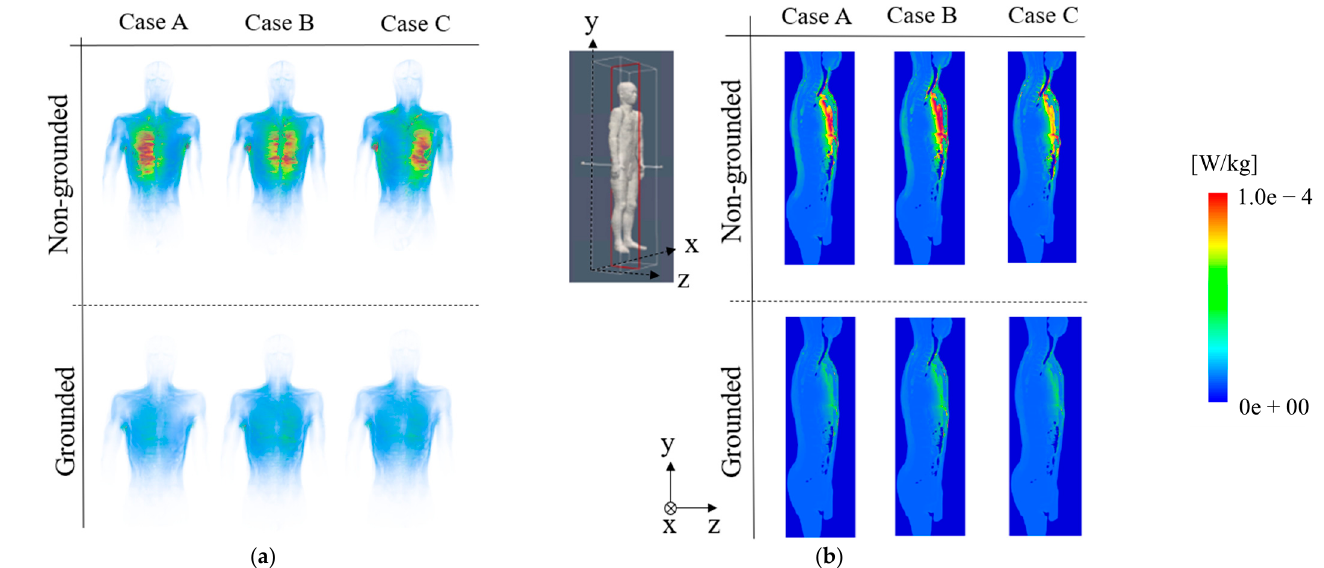
Figure 10. Local SAR distributions on TARO. ( a ) Body surface. ( b ) Cross-sectional plane of input power 1 W, and transmission distance d = 9 cm.